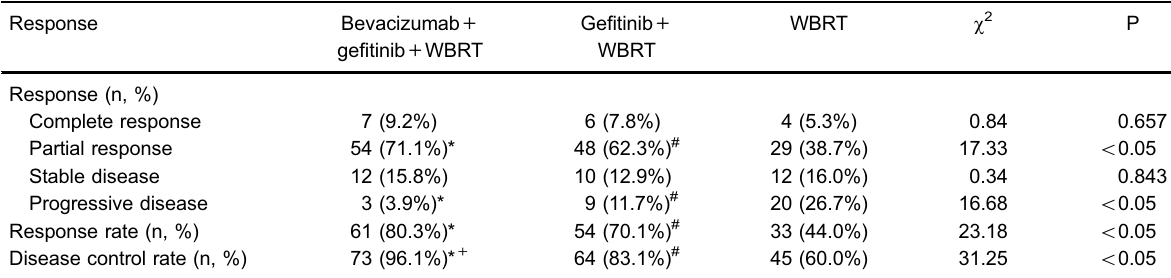
Table 2. Responses in patients with brain metastases due to non-small-cell lung cancer treated with bevacizumab + ge fi tinib + WBRT, ge fi tinib + WBRT and WBRT. Response